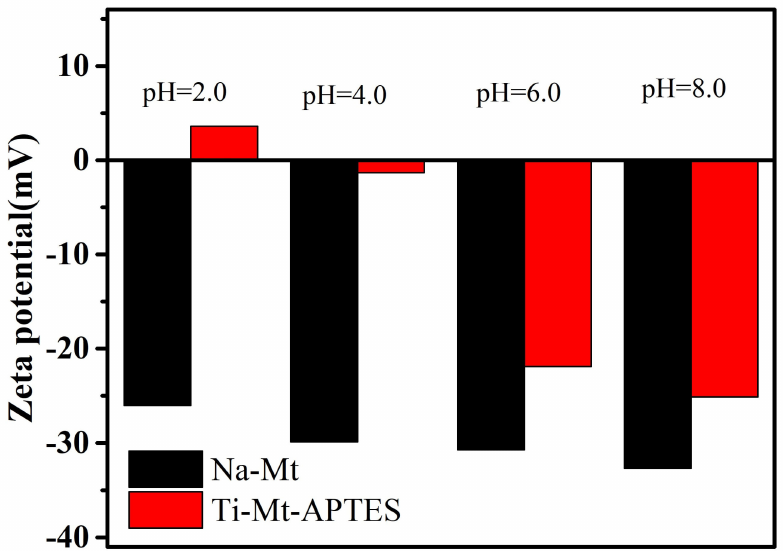
Figure 12. Zeta potentials of Na-Mt and Ti-Mt-APTES at various pH